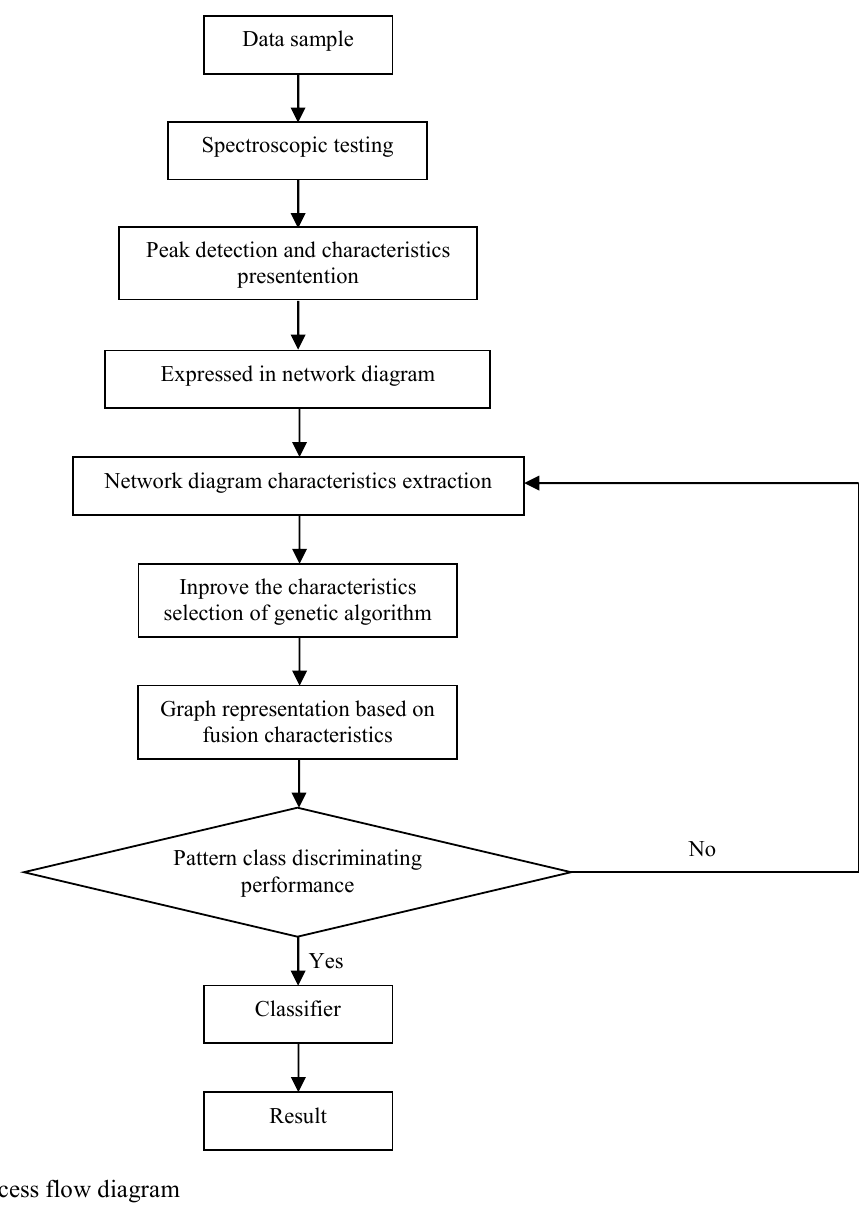
Figure 2. The process flow